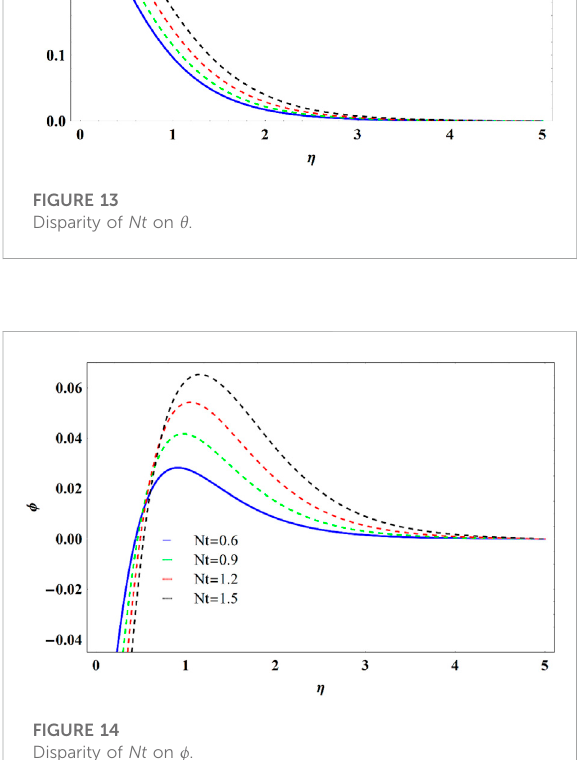
FIGURE 14 Disparity of Nt on ϕ .